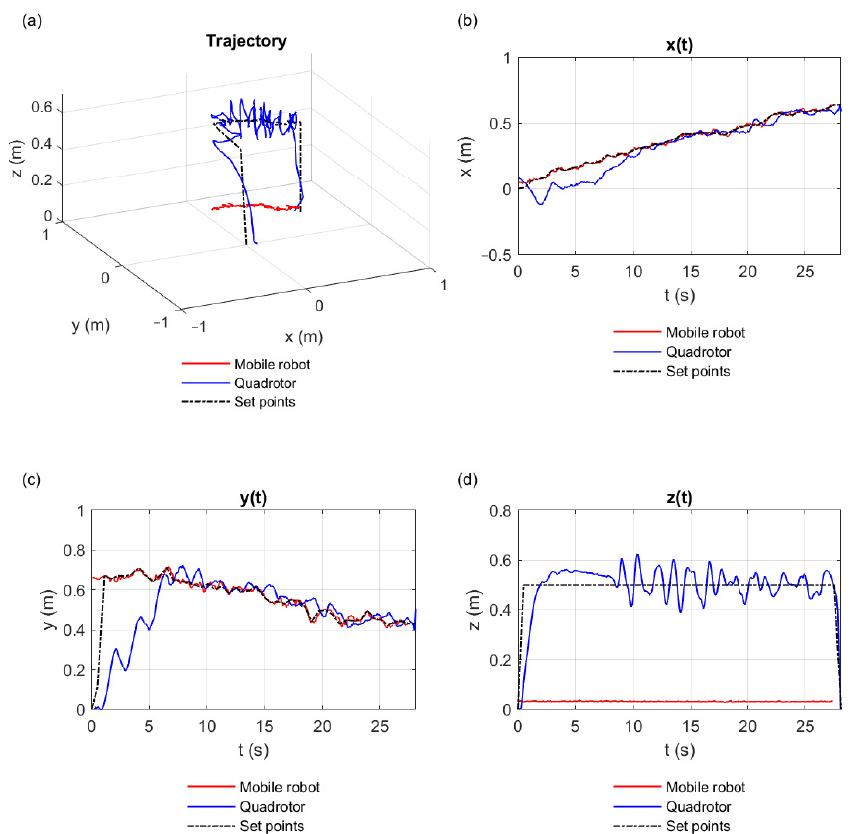
Figure 11. The paths taken by the EV3 (blue line), and the Crazyflie quadcopter robot (red line) compared to the ideal path (black dashed line). ( a ) The trajectory performed in 3D perspective. ( b ) Displacement in x . ( c ) Displacement y . ( d ) Displacement in z .